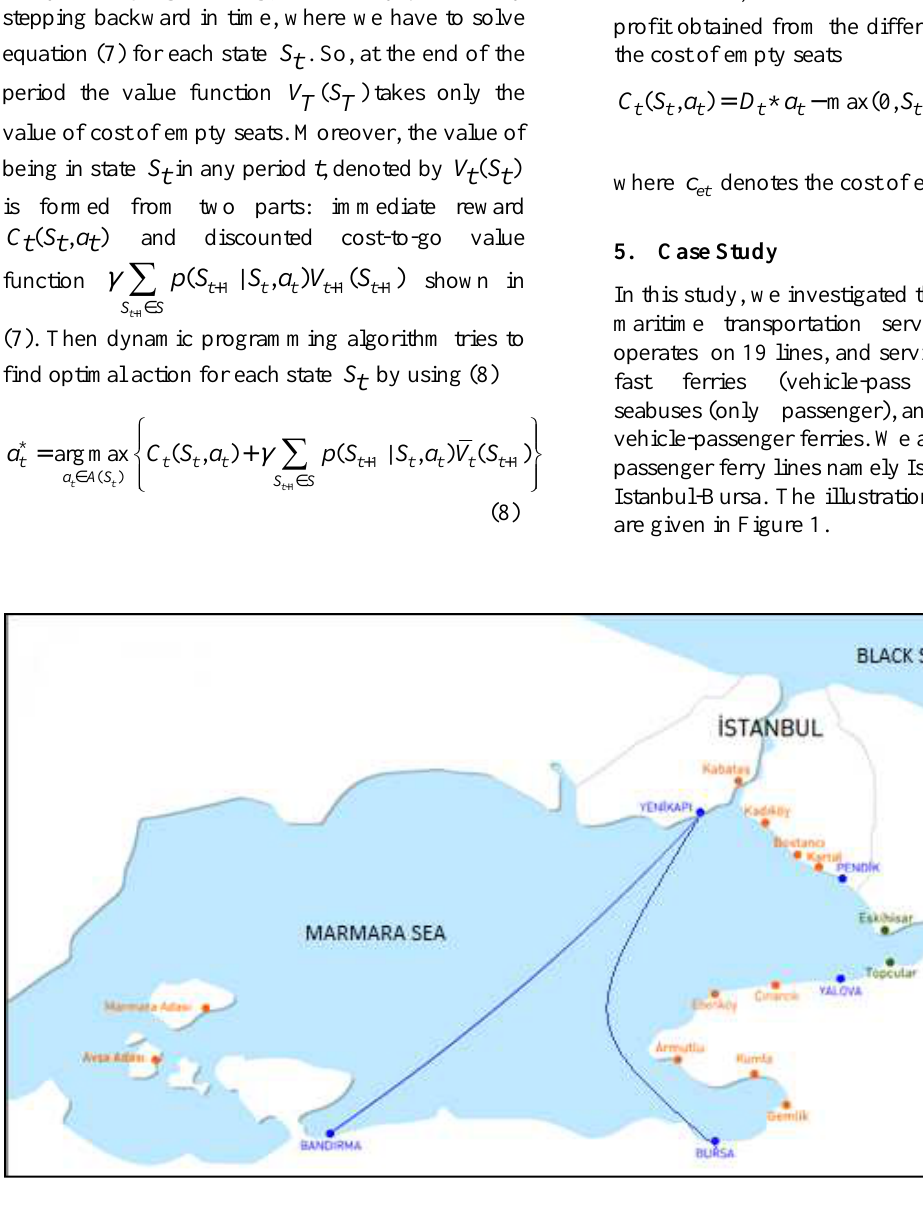
Fig. 1. Ferry lines used in our case